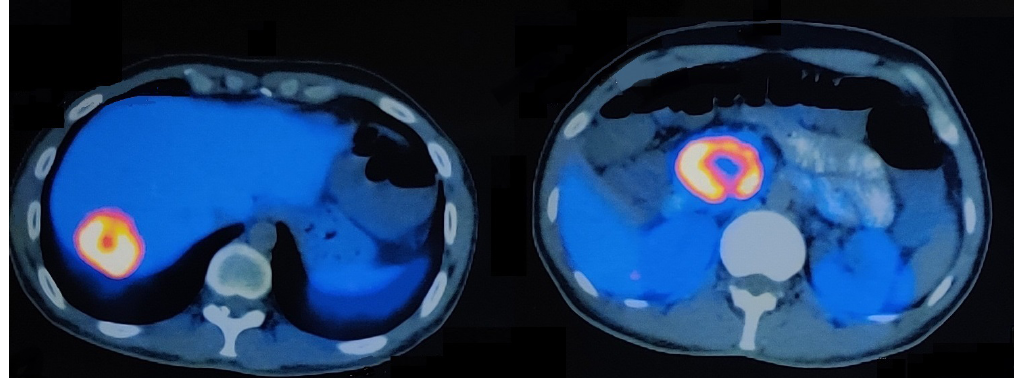
Figure 3. Axial section images of 68 Ga DOTA-NOC PET CT scan showing enhancing lesions in the segment VII of liver (SUV max-14.7) and head of pancreas (SUV